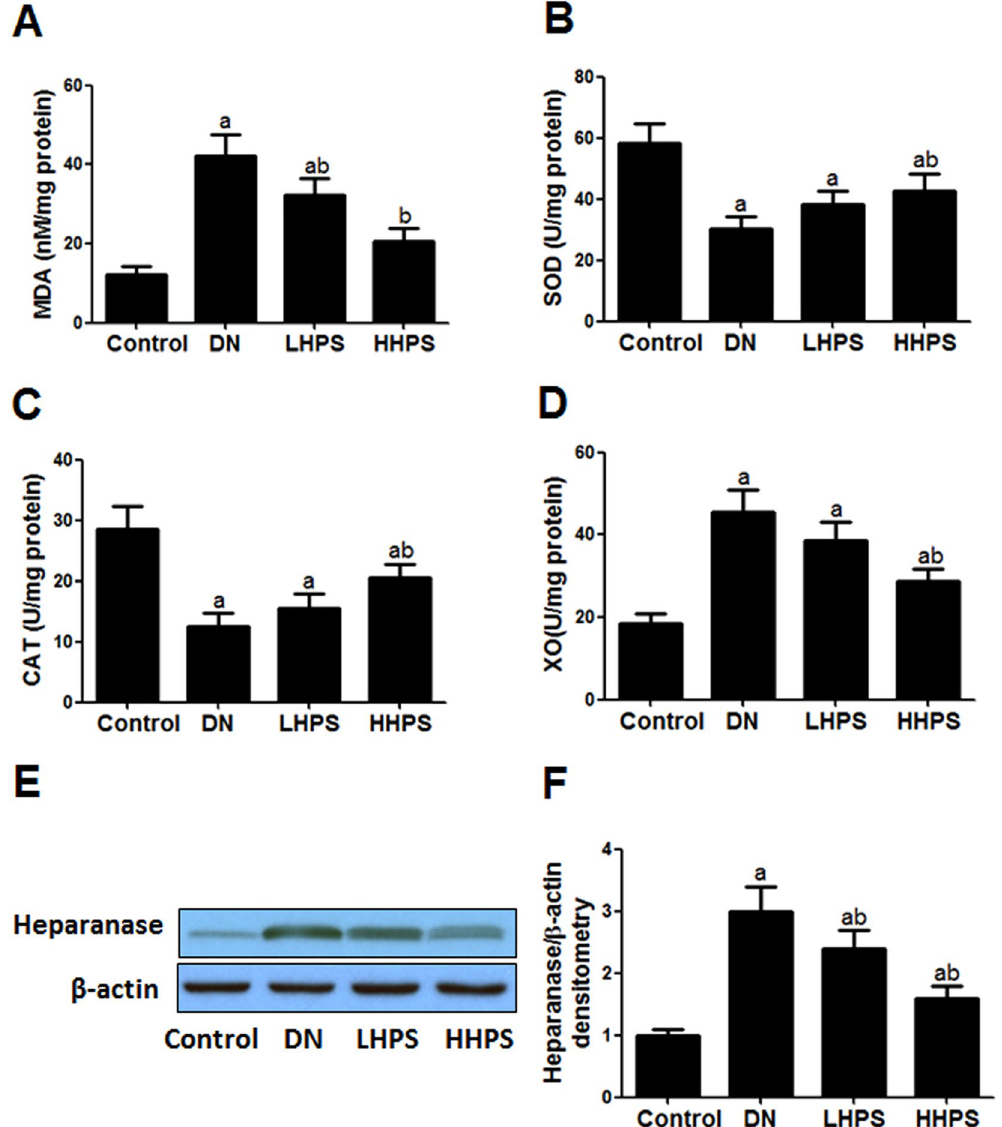
Figure 1. Hyperoside pre-treatment alleviated renal cortex oxidative stress and heparanase protein expression in DN mice (n = 15). ( A ) The levels of ROS-related end product MDA in renal cortex were measured among indicated groups. ( B – D ) The activity of ROS-related enzymes SOD, CAT and XO was measured among indicated groups. ( E , F ) Renal cortex heparanase protein expression was detected by western blot analysis and the columns showed the relative quatification of heparanase protein levels normalized to β -actin. Control: Normal mice; DN: DM mice were treated with vehicle solution for four weeks; LHPS and HHPS: DM mice were treated with 10 or 30 mg/kg/d hyperoside for four weeks respectively from two weeks after DM establishment. Data are presented as mean ± SD. P < 0.05 is statistically significant. a Indicates significant vs. Control, b indicates significant vs.